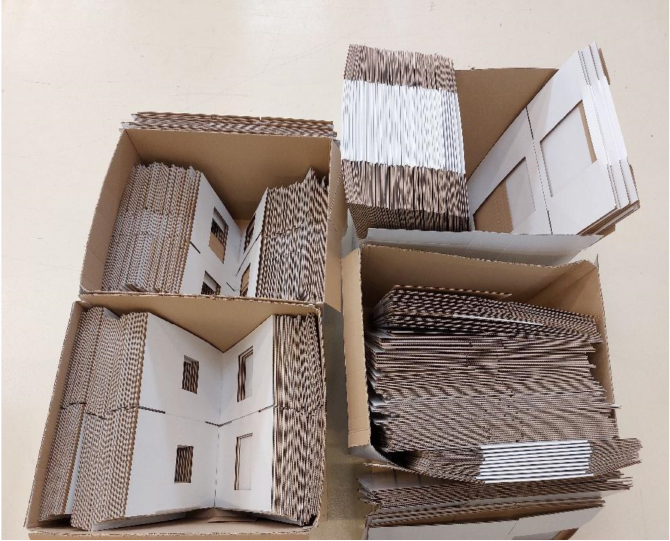
Figure 4. Corrugated cardboard box samples used for this